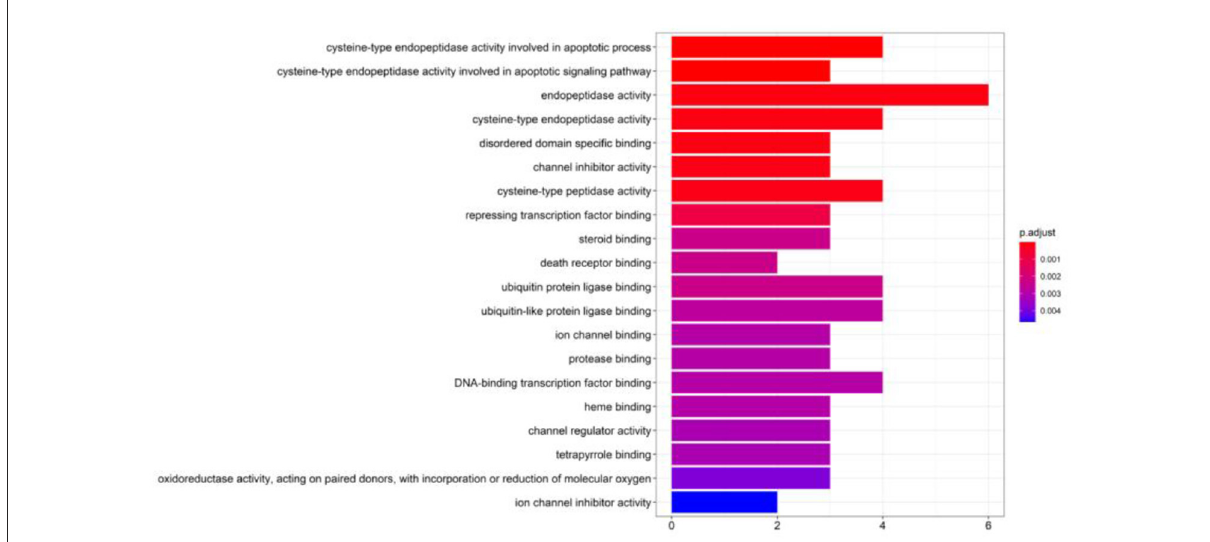
FIGURE6 Kyoto Encyclopedia of Genes and Genomes (KEGG) pathway enrichment analysis of the top 20 pathways. Color represented p -value and size of the spot represented the count of genes.